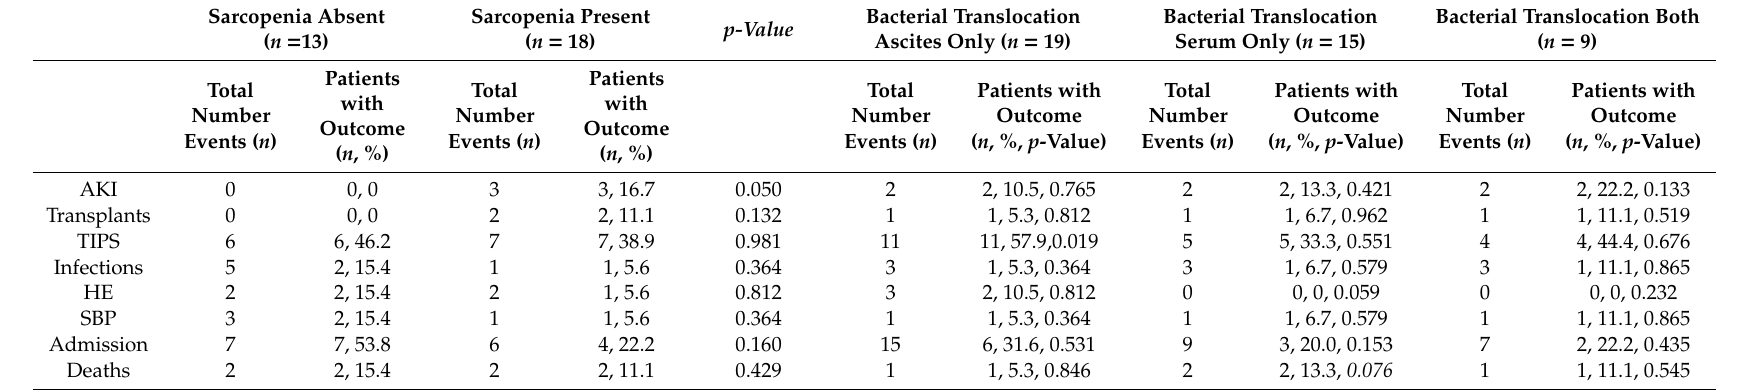
Table 3. Clinical outcomes stratified by sarcopenia and bacterial translocation